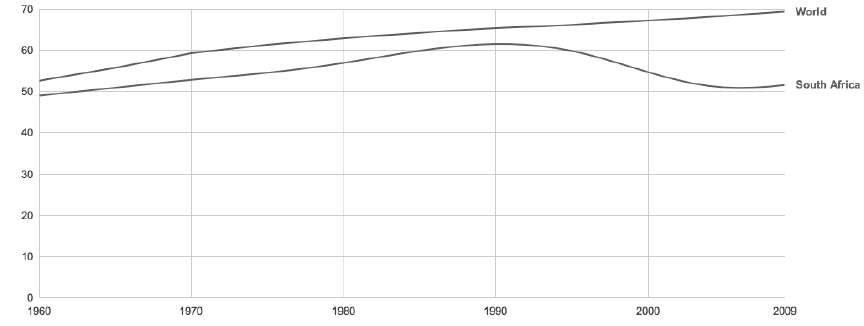
FIGURE 1: Life expectancy of SA compared to the rest of the world Source: World Bank